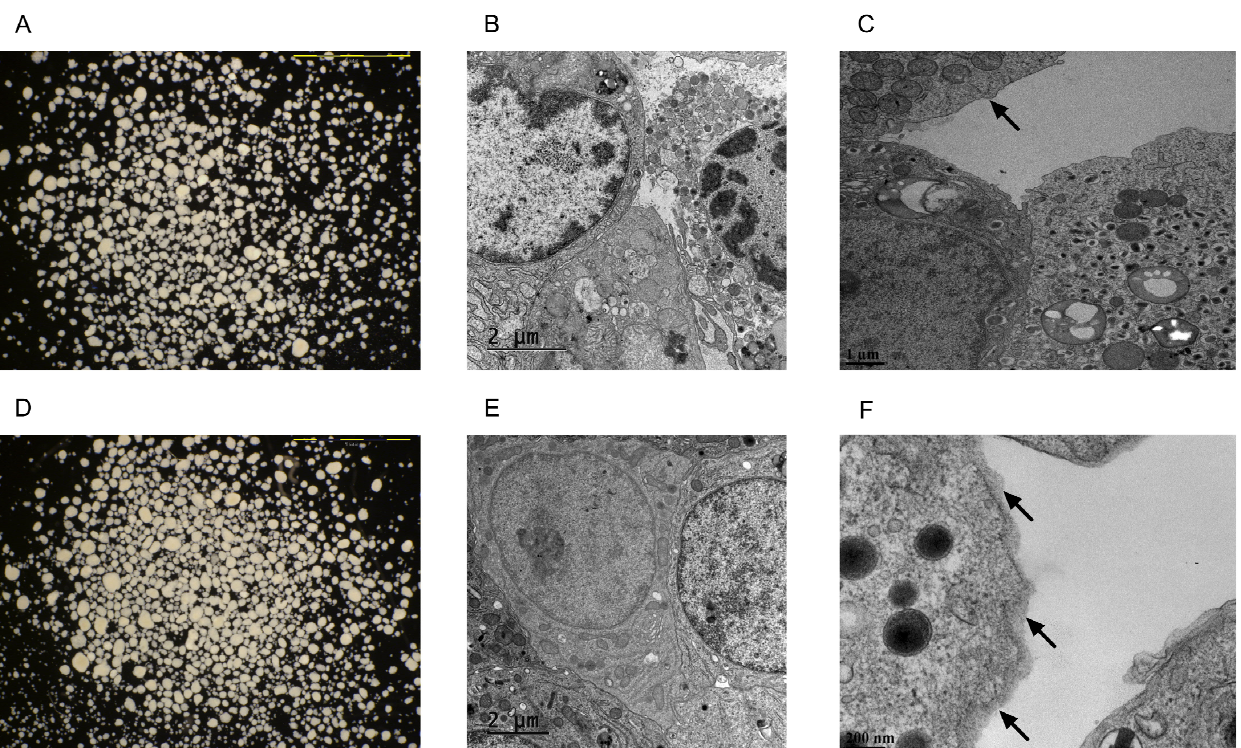
Figure 1. Photomicrographs and transmission electron microscopy images of non-coated ( A – C ) and PVPON/TA-coated ( D – F ) human islets. The scale bars are 1 mm in both light microscopy images. Non-coated ( B ) and PVPON/TA-coated ( E ) human islets were transplanted under the kidney capsule of B6.129S7-Rag 1tm1Mom /J mice. Non-coated ( D ) and PVPON/TA-coated ( F ) human islets one day post-coating. The arrows point to the edges of the islet.